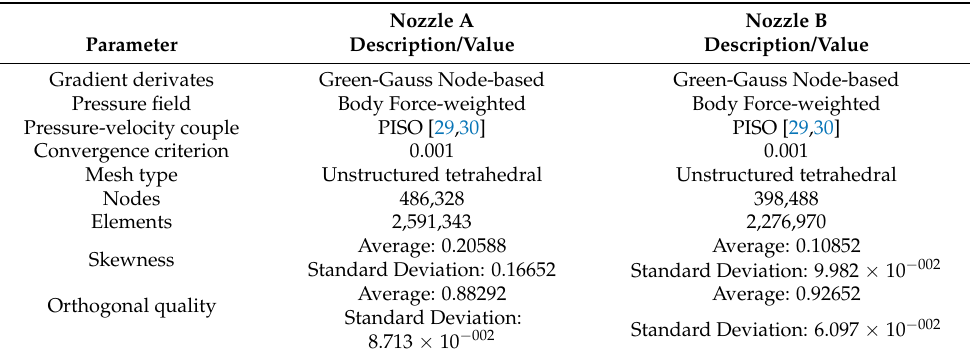
Table 2. Computing procedures and numerical